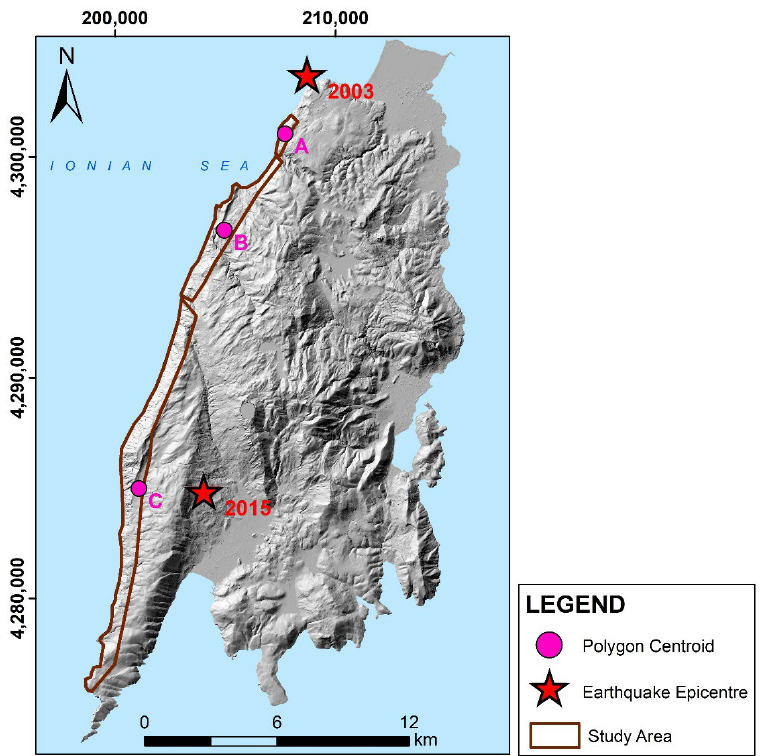
Figure 5. Epicentre locations of the recent strong earthquakes in the Lefkada island and polygons centroids for the distance calculation (the limits of the map correspond to the GGRS87).